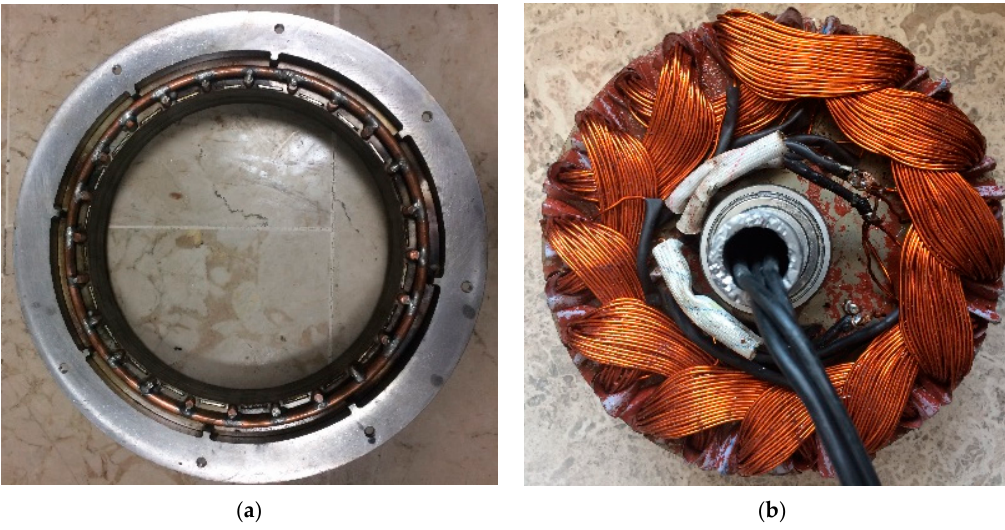
Figure 8. Prototype motor for the Type-D configuration ( a ) outer rotor ( b ) inner stator.